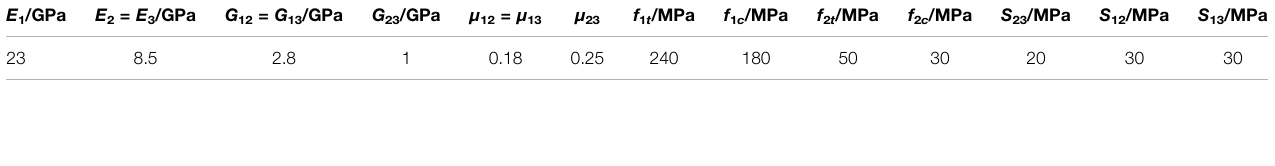
TABLE A1: Elastic modulus and strength of the pultruded GFRP pro fi le for the test